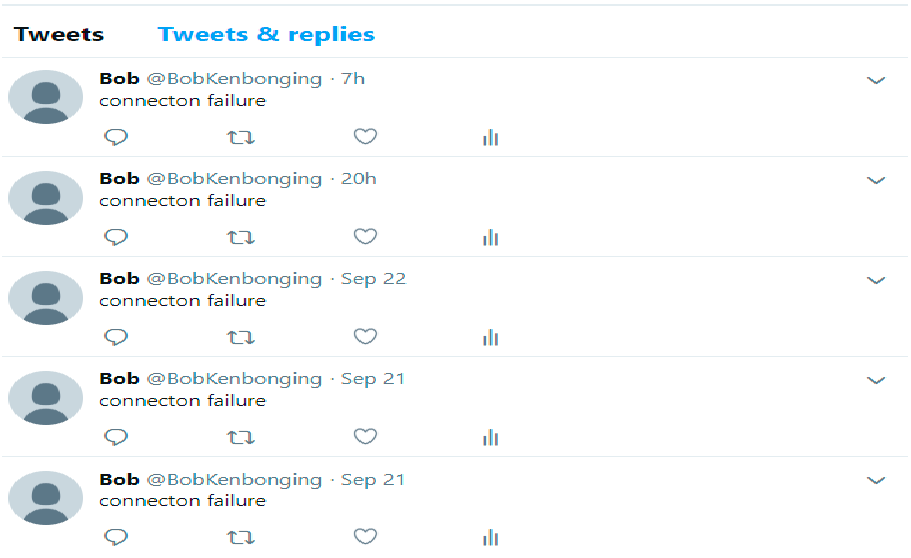
Figure 16. Connection failure message on the user’s Twitter account.